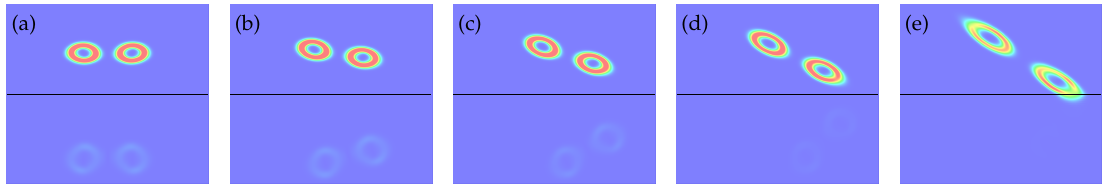
Figure 14. Incident-angle dependence of refracted and reflected toroidal-vortices for (cid:101) 2 / (cid:101) 1 = 2.50. The incident angle is ( a ) 0 ◦ , ( b ) 15 ◦ , ( c ) 30 ◦ , ( d ) 45 ◦ and ( e ) 60 ◦ from left to